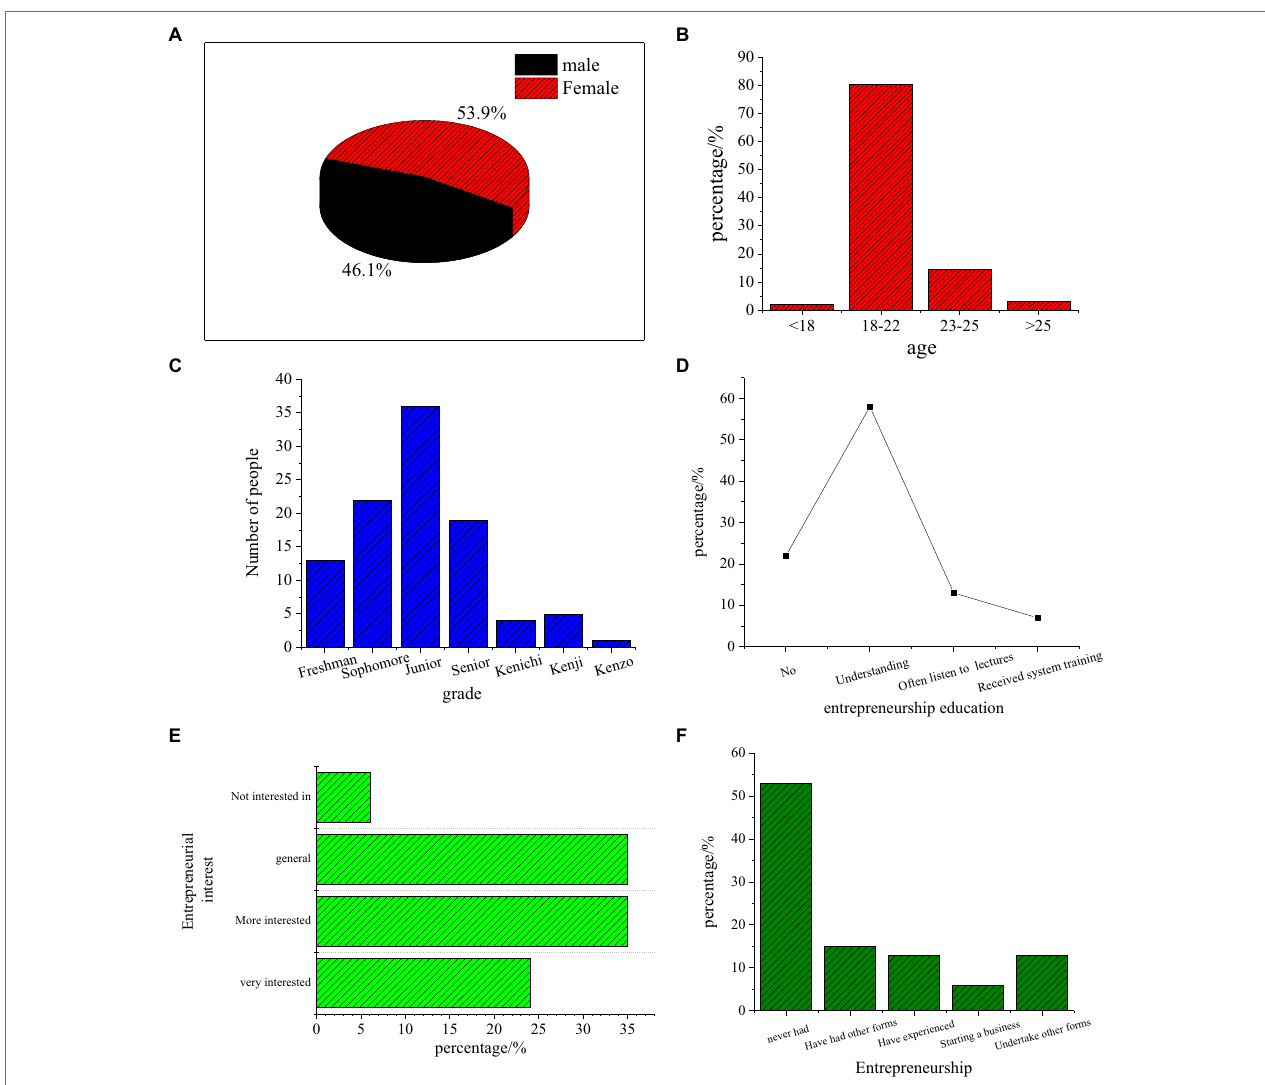
FIGURE 1 | QS statistics. (A) Gender, (B) Age, (C) Grade, (D) IEE education, (E) Entrepreneurial intention, and (F)